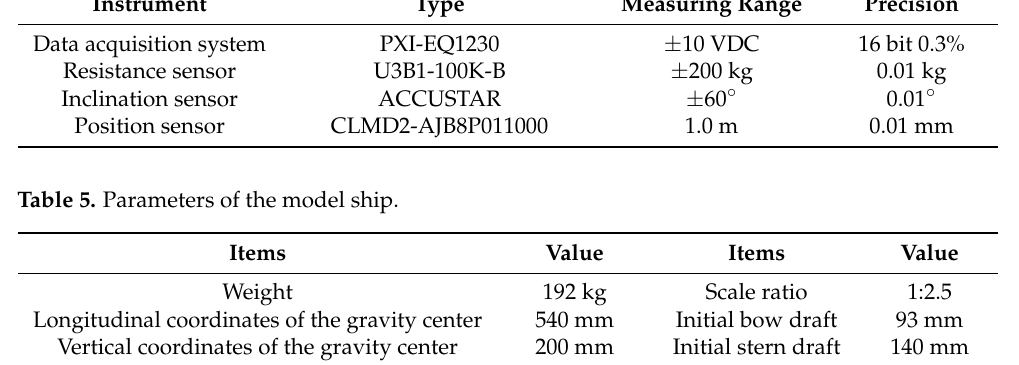
Figure 10. Comparison of the surface wave between EFD and CFD.